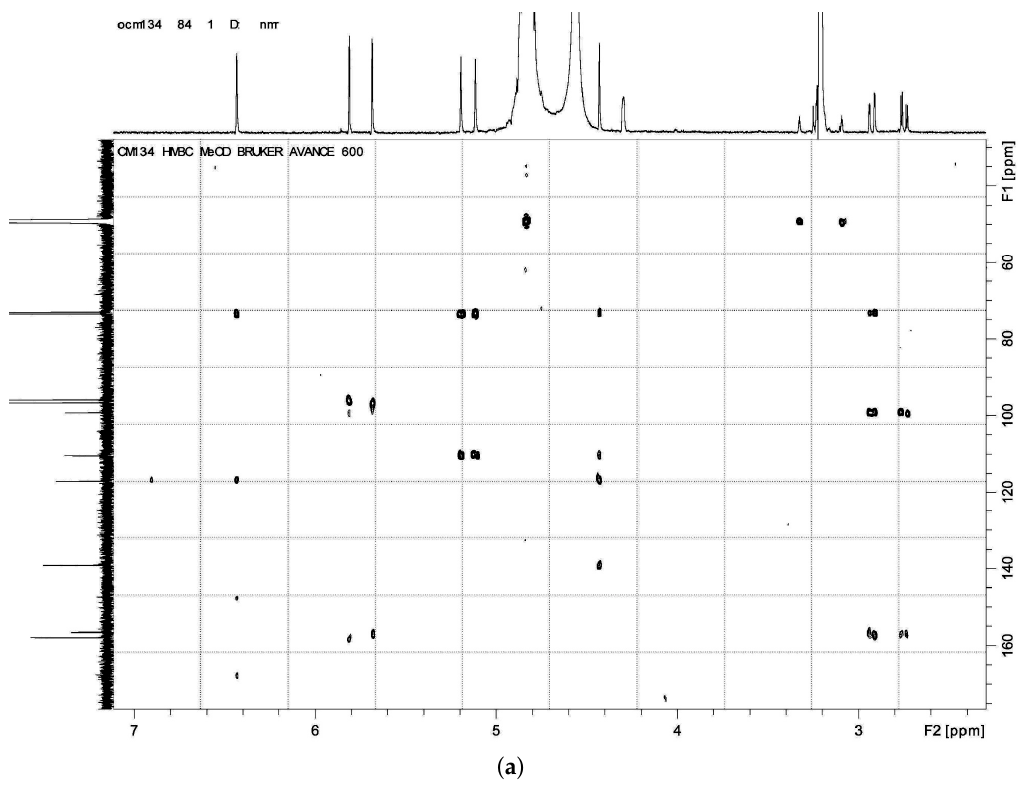
Figure 4. Cont. Figure 4.